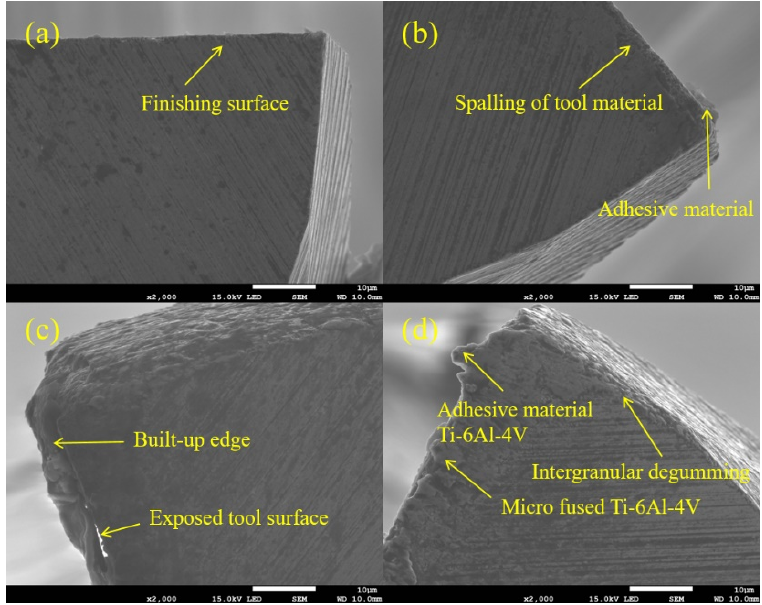
Figure 14. SEM microscopic images of micro-milling cutter under different wear states. ( a ) Initial’s SEM image and wear form, ( b ) Wear I’s SEM image and wear form, ( c ) Wear II’s SEM image and wear form and ( d ) Wear III’s SEM image and wear form.